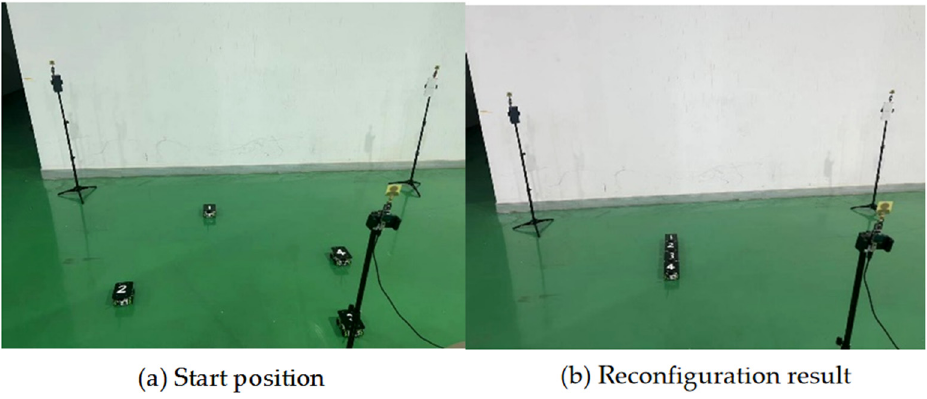
Figure 25. “ | ” shape reconfiguration procedure.